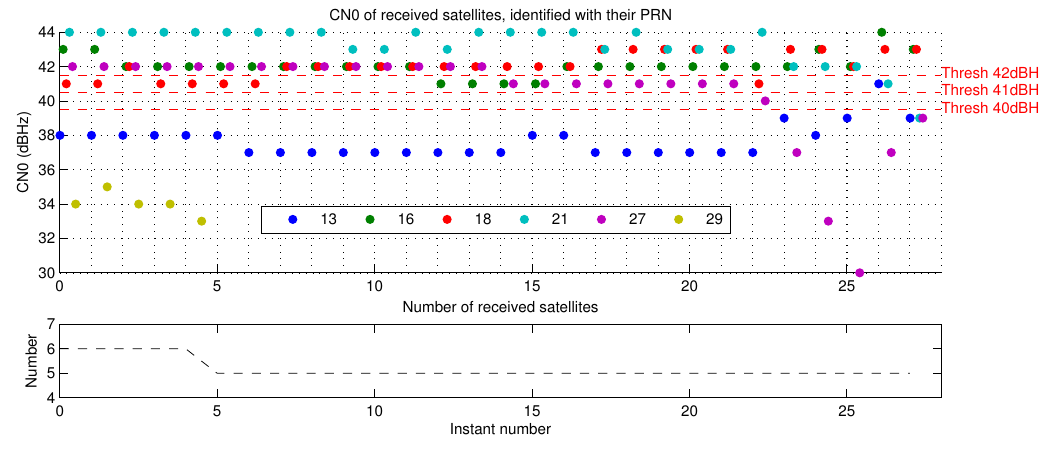
Figure 17. Satellites CN0 for sequence